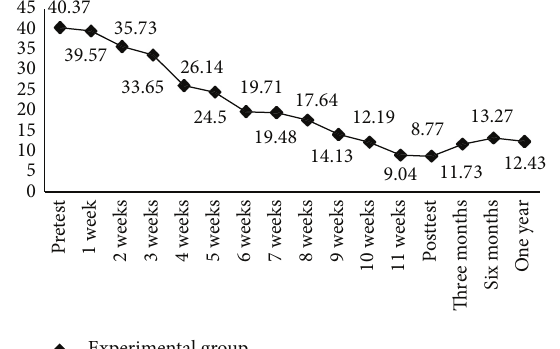
Figure 3: Changes in HRSD scores at the various follow-up